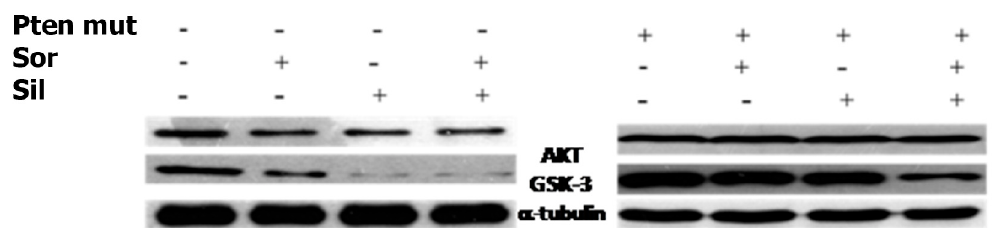
Figure 6. Silybin increases the cytotoxic effect of sorafenib. Effects of silybin (sil), sorafenib (sor) on AKT, GSK3 expression, in HepG2 cells transfected or not, with mutated PTEN (PTEN mut) was evaluated by Western blotting. γ -tubulin was used as loading control; standard deviation from the mean in at least three independent experiments.